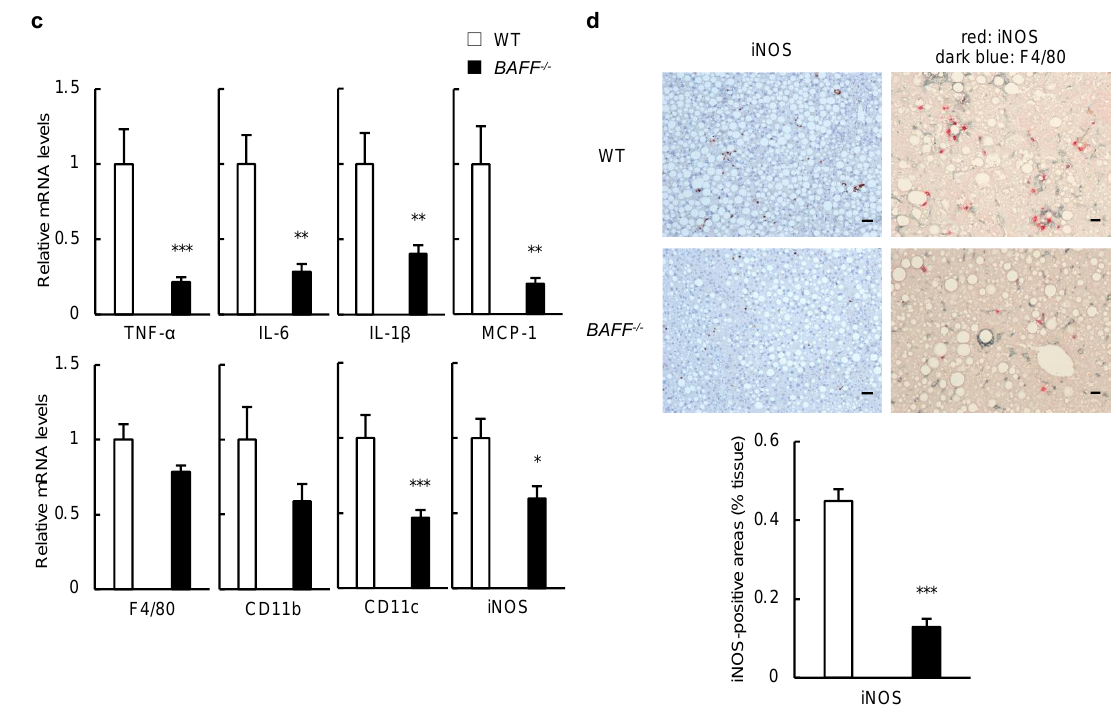
Figure 2. Liver inflammation is attenuated in BAFF − / − mice in murine models of NASH. ( a ) Representative F4/80 staining of the liver from HFHCD/CCl 4 -treated WT and BAFF − / − mice (left). The arrows point to the CLSs formed by macrophage aggregation. Quantitative measurement of CLSs (right) (scale bar, 100 µ m; images from six different fields; n = 8/group); ( b ) Representative flow cytometry contour plots showing frequencies of F4/80 + CD11b + CD11c + cells (M1 macrophages) among liver NPCs isolated from liver from HFHCD/CCl 4 -treated WT and BAFF − / − mice (upper). The ratio of quantification of M1 macrophages and F4/80 + CD11b + CD11c − cells (M2 macrophages) isolated from liver NPCs (lower) ( n = 7/group); ( c ) Relative mRNA levels of the indicated genes in the liver from HFHCD/CCl 4 -treated WT and BAFF − / − mice ( n = 10–15/group); ( d ) Representative iNOS and F4/80 staining (upper) and quantification of the iNOS-positive area (lower) of liver from with HFHCD/CCl 4 -treated mice. The iNOS-positive macrophages were detected as reddish and dark bluish (scale bar, 100 µ m; images from seven different fields; n = 5/group). For all bar plots shown, data represent mean ± standard error of the mean. * p < 0.05, ** p < 0.01, and *** p < 0.001. BAFF, B cell-activating factor; NASH, non-alcoholic steatohepatitis; HFHCD, high-fat/high-cholesterol diet; WT, wild-type; CLSs, crown-like structures; NPCs: non-parenchymal cells; TNF, tumor necrosis factor; IL, interleukin; MCP-1, monocyte chemotactic protein-1; iNOS, inducible nitric oxide